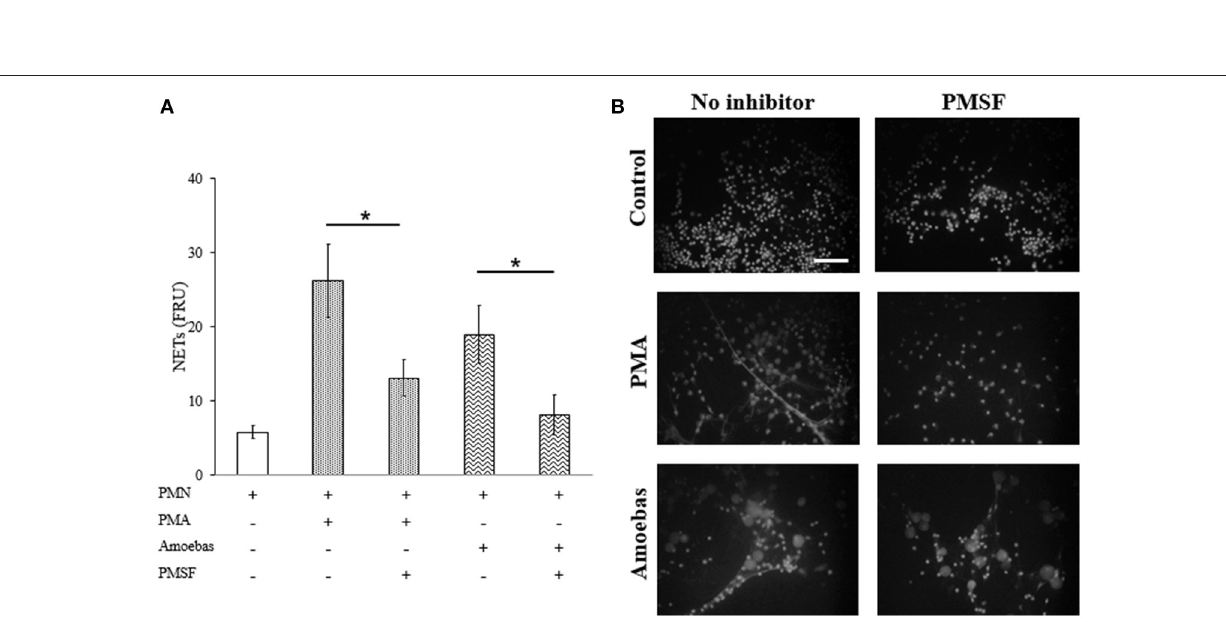
FIGURE 9 | Neutrophil elastase (NE) translocation to the nucleus take place during NETosis induced by trophozoites. Non-stimulated neutrophil (2 × 10 5 ) and neutrophils stimulated by 20nM PMA or co-culture with 1 × 10 4 trophozoites during 4h were fixed and immunofluorescence performed using anti-NE antibody and anti-mouse IgG conjugated to FITC. DNA was staining with DAPI. Arrowheads indicate nuclear localization of NE. Images were taken at 100x magnification. Scale bar 50 µ m.